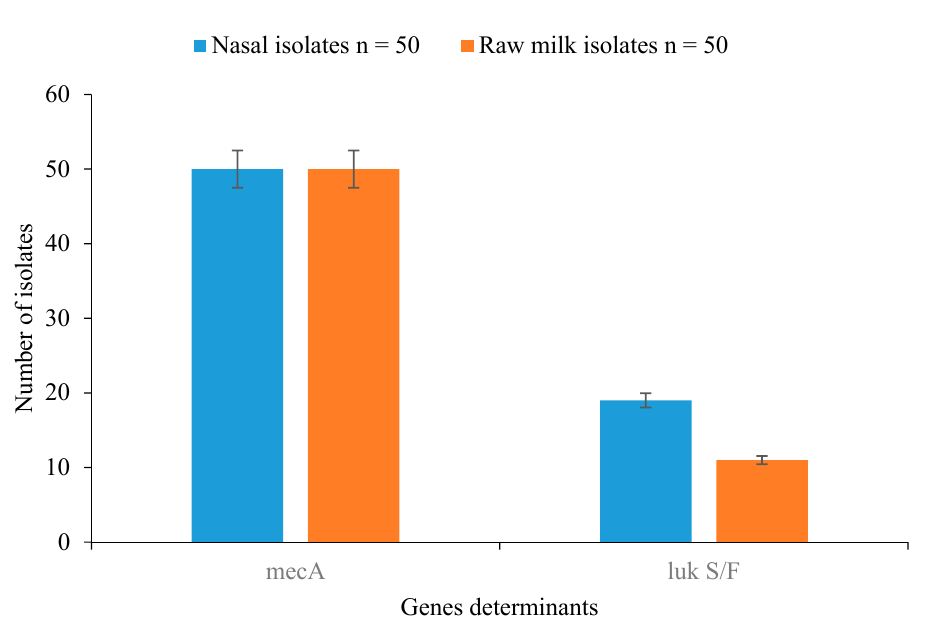
Figure 1. Detection of resistance and virulence genes in Staphylococcus spp. isolated from nasal cavity and raw milk samples.